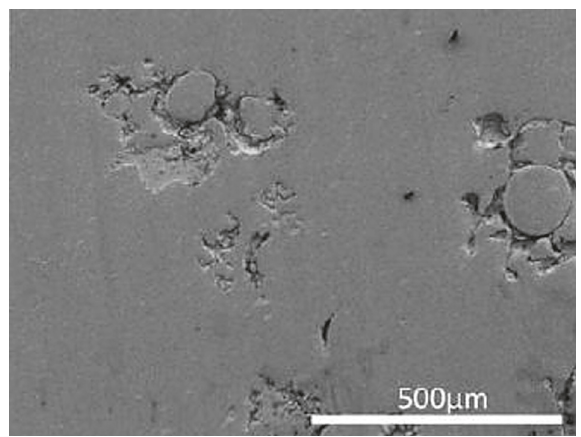
Figure 8: SEM figure of the composite sample that was mixed with a hardener in only 5 minutes (IMM) [119] (copy with permission from